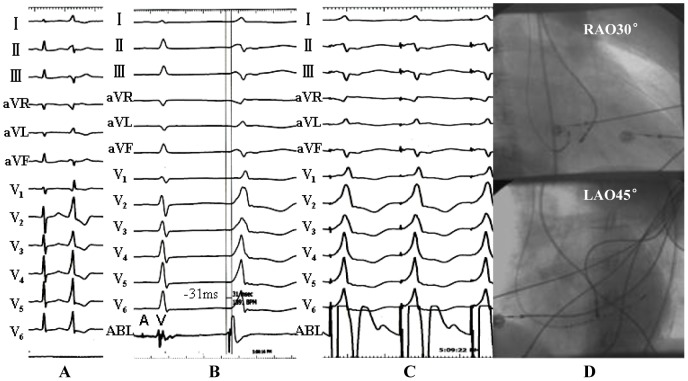
Example of a successful ablation of idiopathic premature ventricular contraction originating from the posteroseptal portion of the endocardial mitral annulus.(A) The surface ECG characteristic. (B) The local ventricular activation time recorded at the successful ablation site that preceded the onset of the QRS complex was 31 ms. (C) Pace map at the ablation site. (D) The ﬂuoroscopic position of the ablation catheter site.